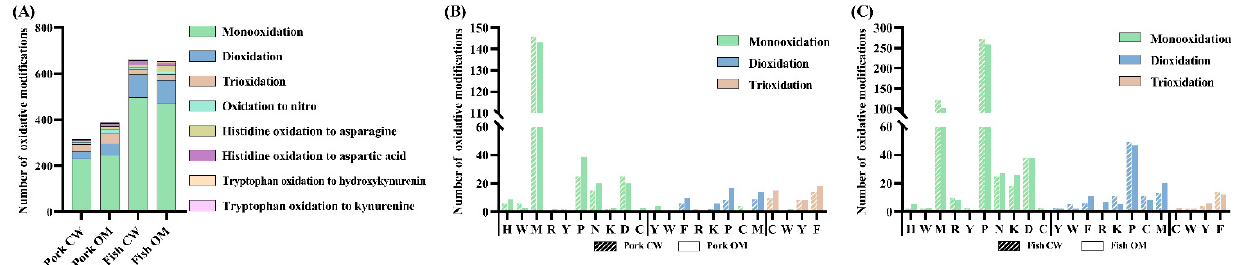
Figure 3. The number of oxidative modifications among all samples ( A ); oxidation sites and the number of monooxidation, dioxidation, and trioxidation modifications in pork sample ( B ); and